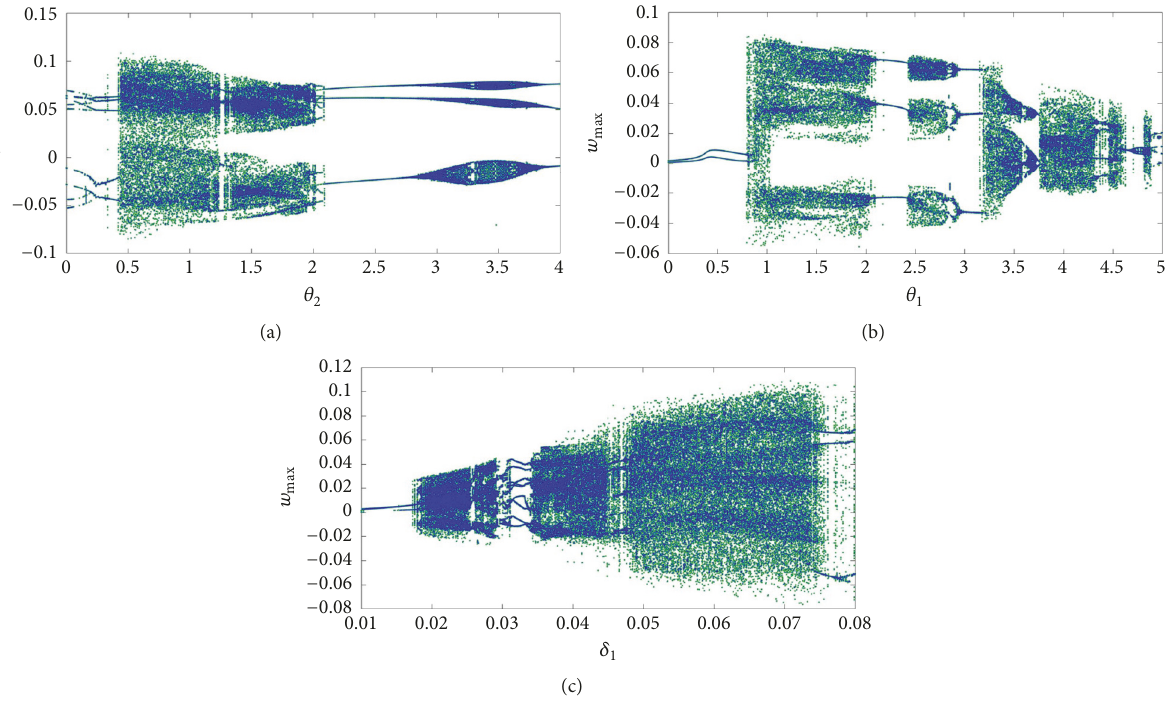
Figure 3: Bifurcation plots of 2DOF SMA with (a) 𝜃 2 , (b) 𝜃 1 , and (c) 𝛿 1 with initial conditions [0,0,0,1]